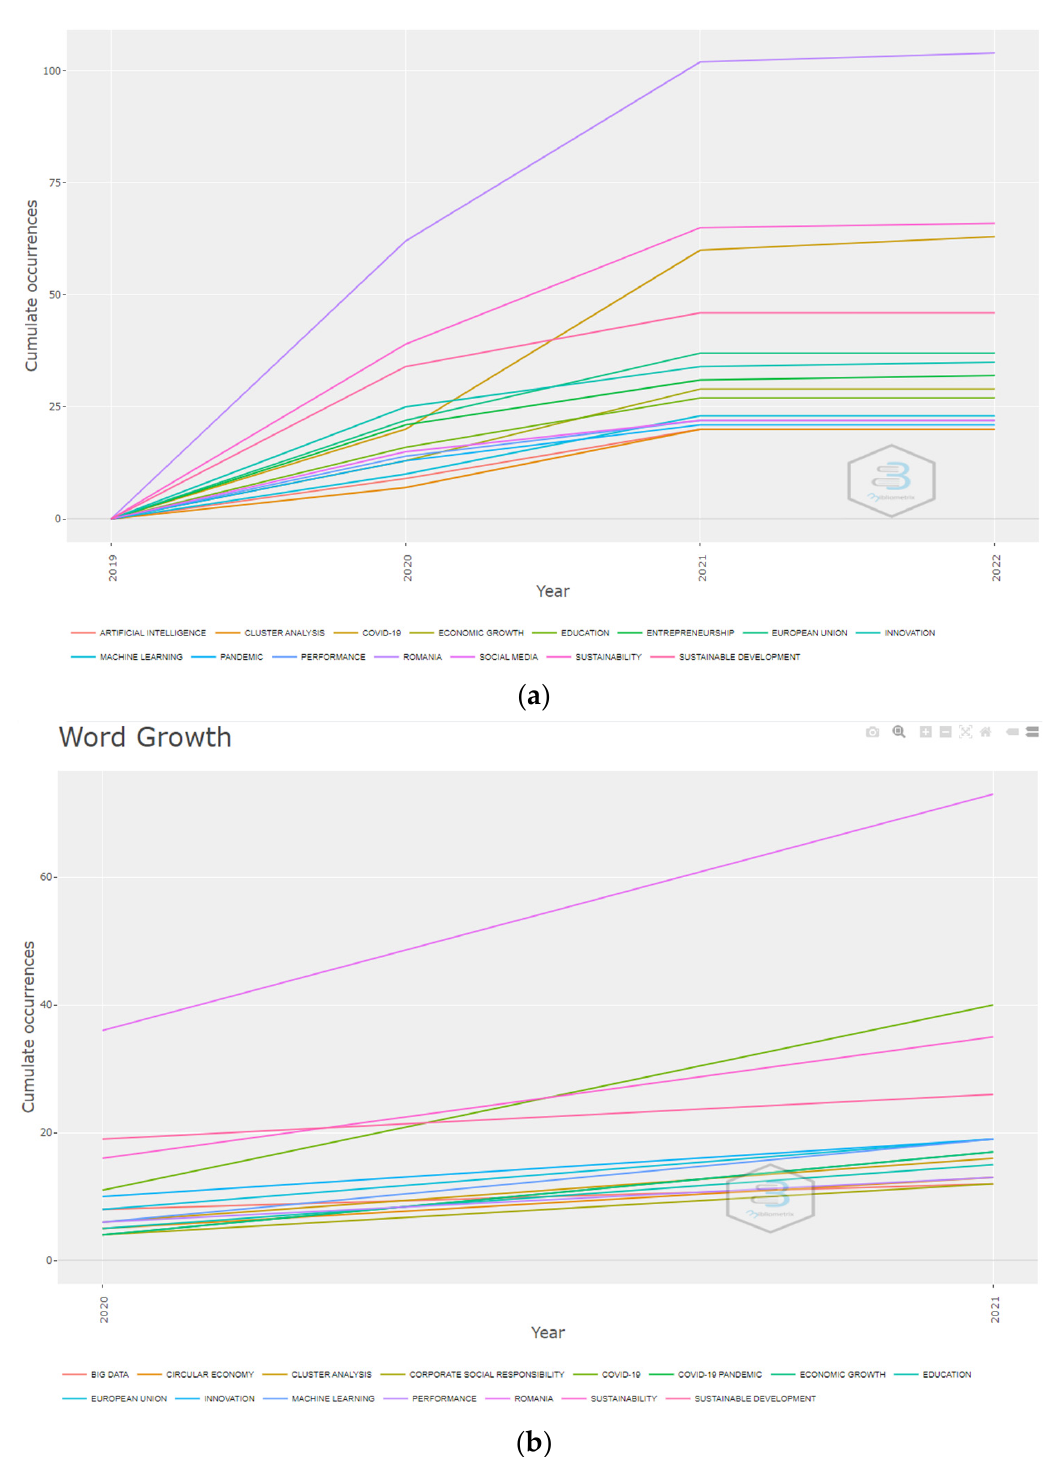
Figure 6. Most frequent keywords in the abstracts of publications. ( a ) WoS. ( b ) Scopus.